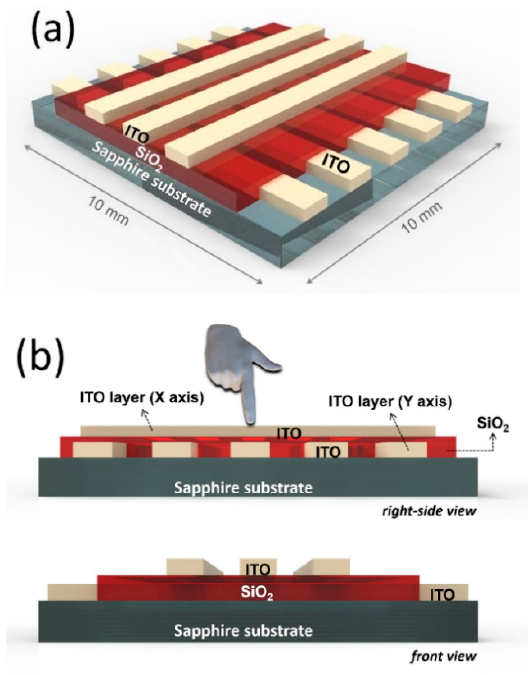
Figure 7. ( a ) Schematic design of ITO/SiO 2 /ITO/sapphire capacitive touch-screen panel (TSP) (10 mm × 10 mm), and ( b ) cross-section view of the TSP representing the ITO layer (X and Y-axis electrodes) and the SiO 2 dielectric layer.